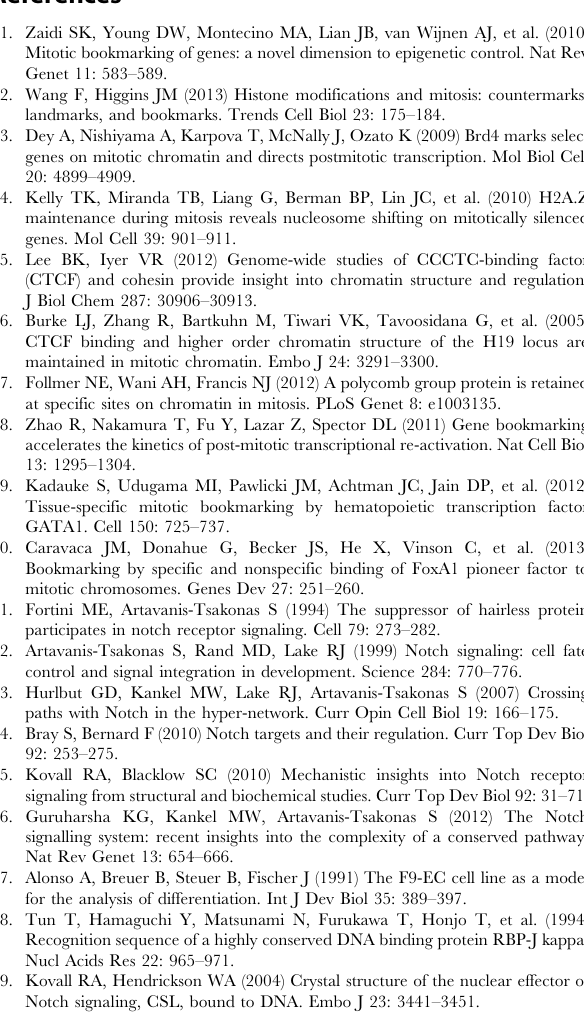
Table S6 Primers used in real-time